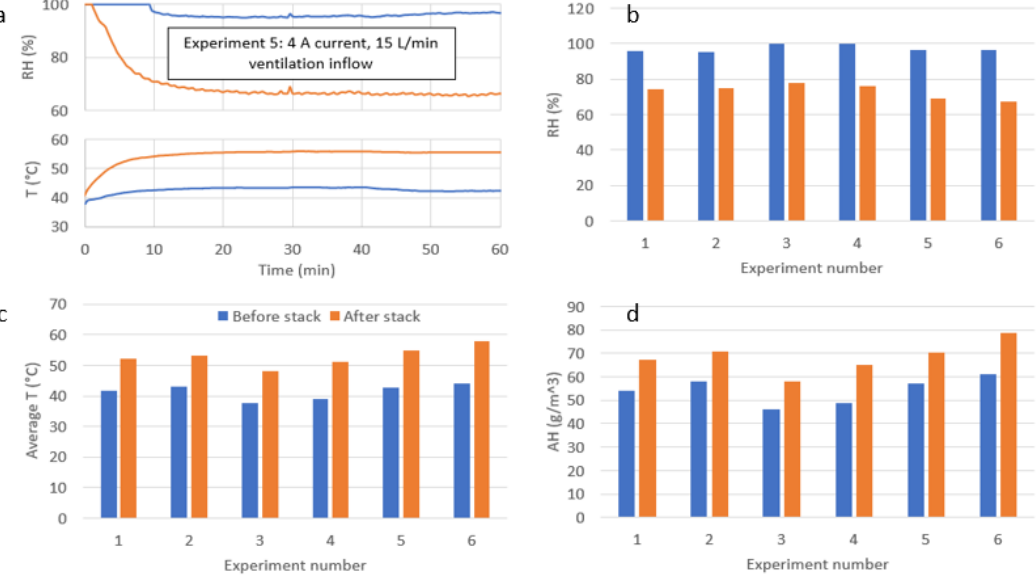
Figure 8. ( a ) A typical variation of temperatures and humidity measured before (blue lines) and after the FC (orange lines) with time. In this case, the operating current was I = 4 A, and the hydrogen flow was V air = 15 L/min. ( b – d ) display the average air temperature and relative and absolute humidity recorded before (blue) and after (orange) the FC.